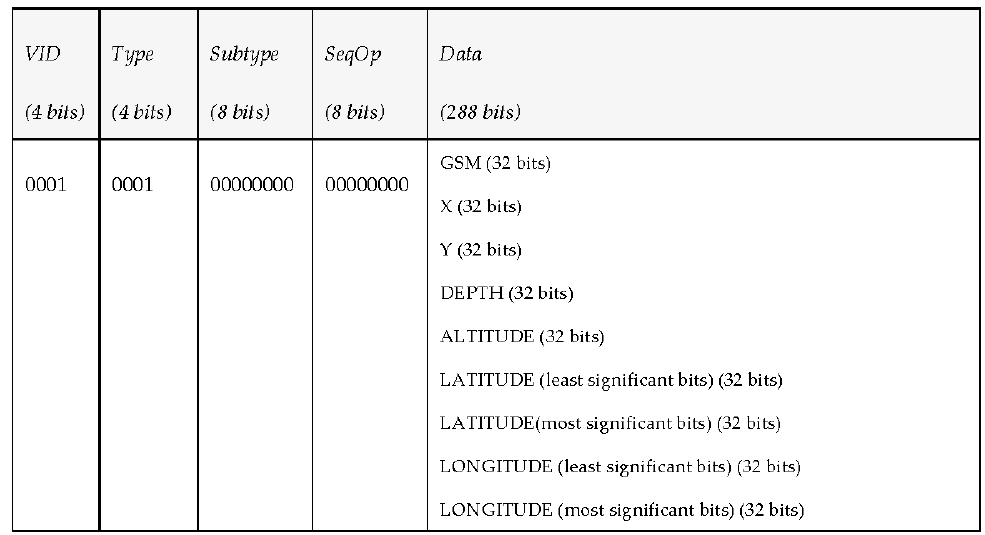
Figure 7. Appearance of the PDU used to send environment information.